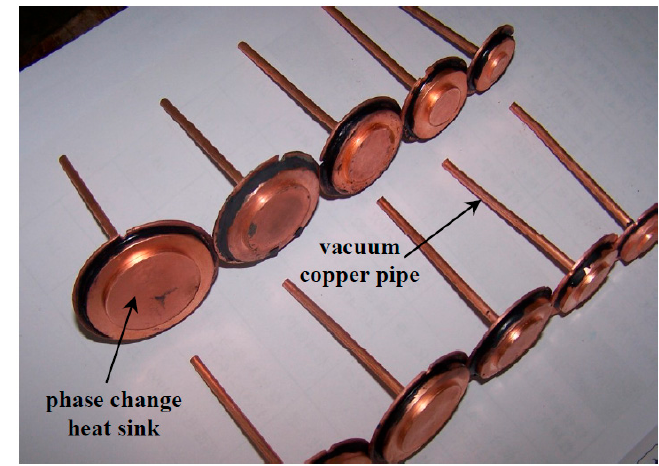
Figure 14. The phase change heat sink specimens.